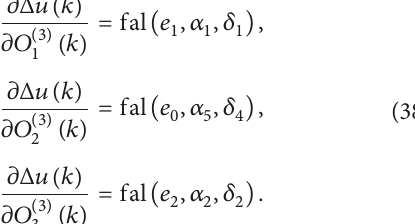
Figure 6: Diagram of the BP neural